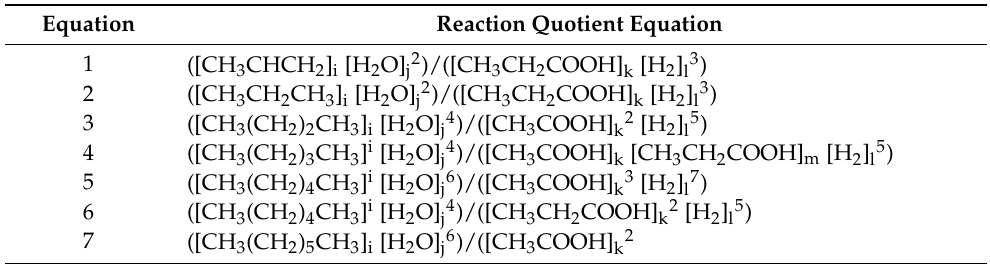
Table 4. Group 2 reaction quotient equations. Subscripts [i, j, k, l, m] are molar concentrations of products and reactants. The equations are constructed using the methodology defined in [31].